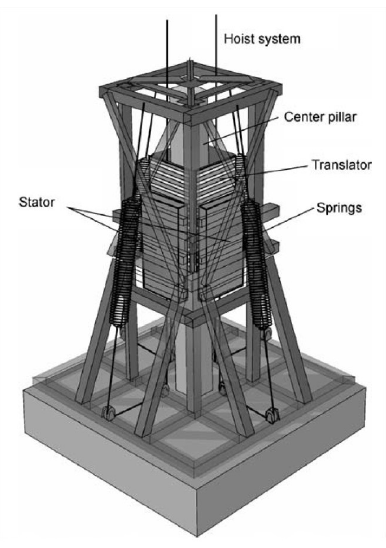
Figure 24. Illustration of a linear generator [69]. Photography supplied courtesy of João Cruz.